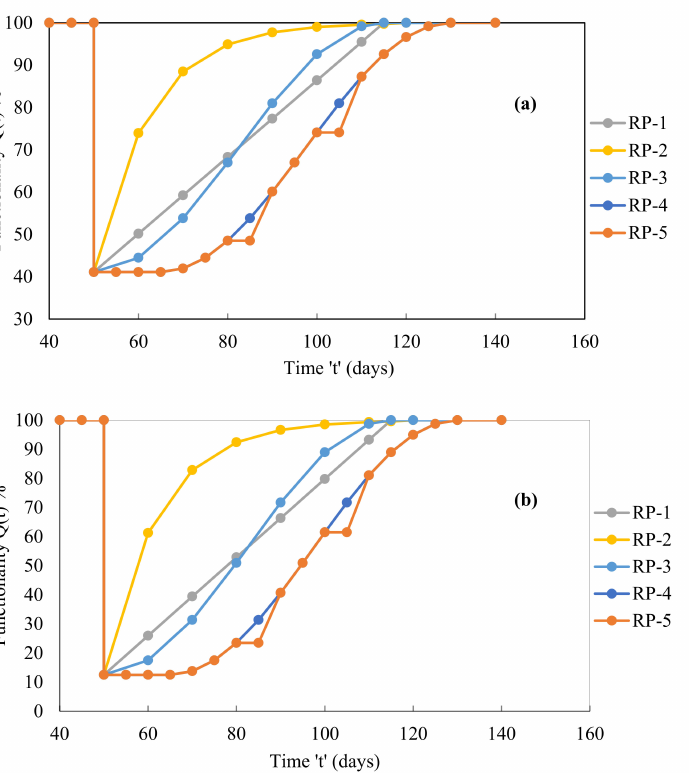
Figure 20. Functionality curves for unsymmetrical building Case IV (R = 6) using various recovery paths ( a ) with respect to DBE level and ( b ) with respect to MCE